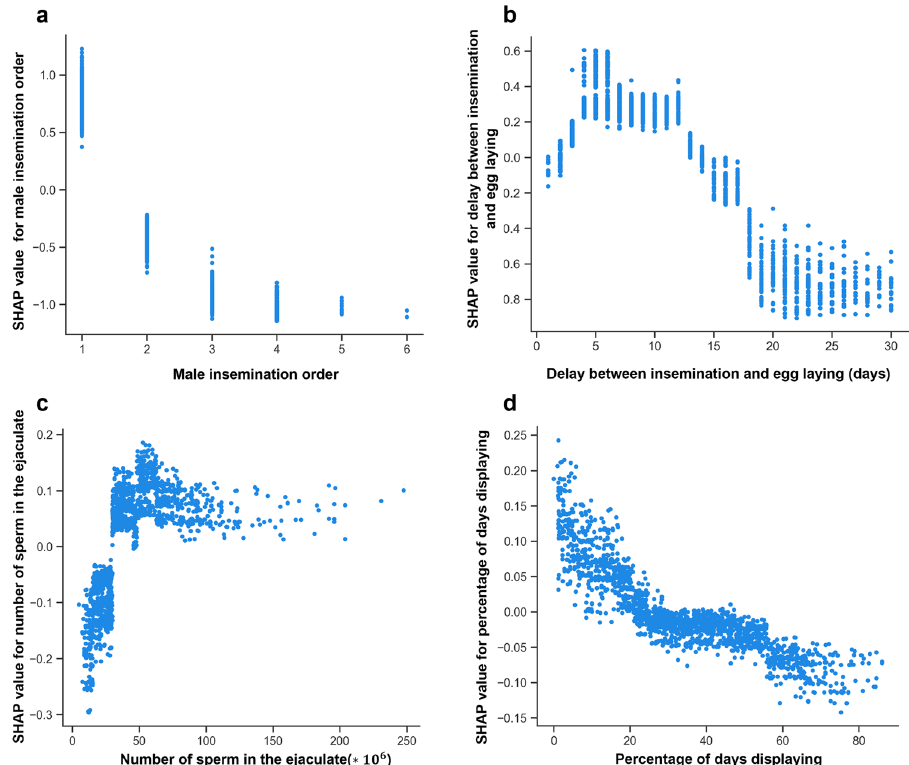
Fig. 2 SHAP partial dependence plot of the main predictors of siring success. a Male insemination order (1 refers to the last male in the sequence); ( b ) delay between the day of egg laying and day of insemination; ( c ) number of sperm in the ejaculate; ( d ) percentage of days displaying prior to the day the ejaculate was collected. Each dot corresponds to one insemination ( N = 2226).